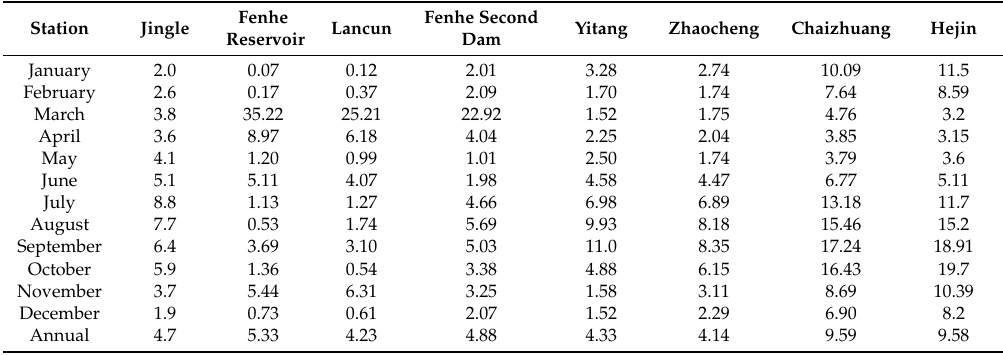
Table 8. Average monthly flow measured by hydrological stations on the main stream of the Fenhe River from 1997 to 2006 (Units = m 3 /s).